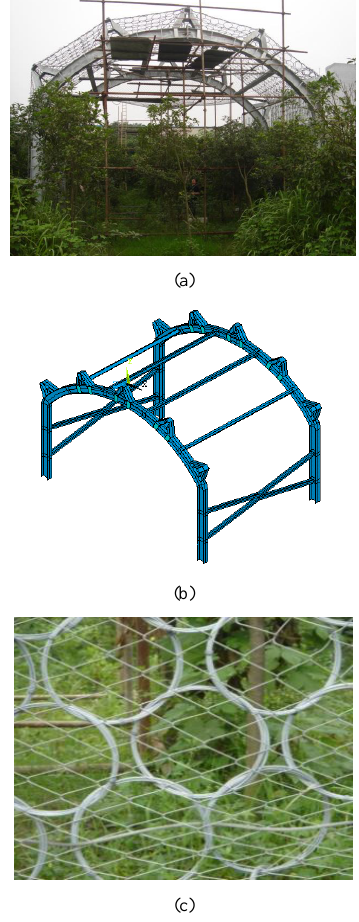
Fig. 4. (a) Flexible rock-shed constructed and tested on Chengdu, China; (b) Steel vaulted structure; (c) Ring nets with diameter 300 mm and TECCO wire meshes G65